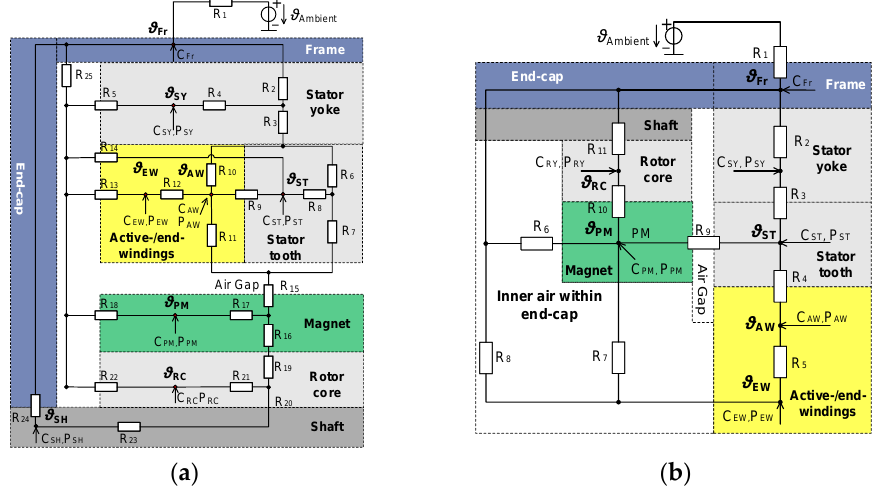
Figure 20. Classical simplified LPTMs for PMSMs. ( a ) “T-type” based [34]. ( b ) “I-type” based [37]. As can be seen from Figures 18–20, all main components within the PMSM need to be involved in any LPTMs to maintain the integrity of the entire thermal network.